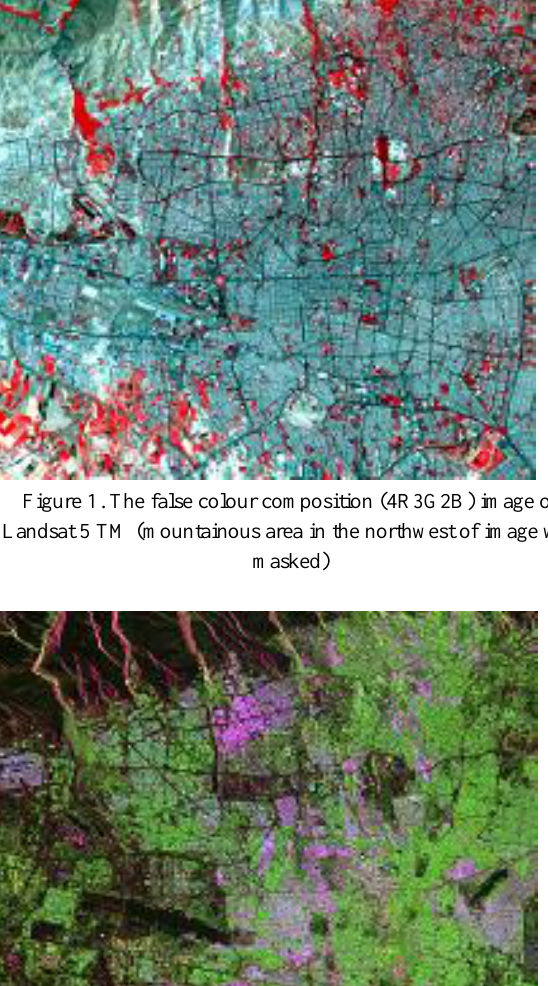
Both images pre-processed independently prior to